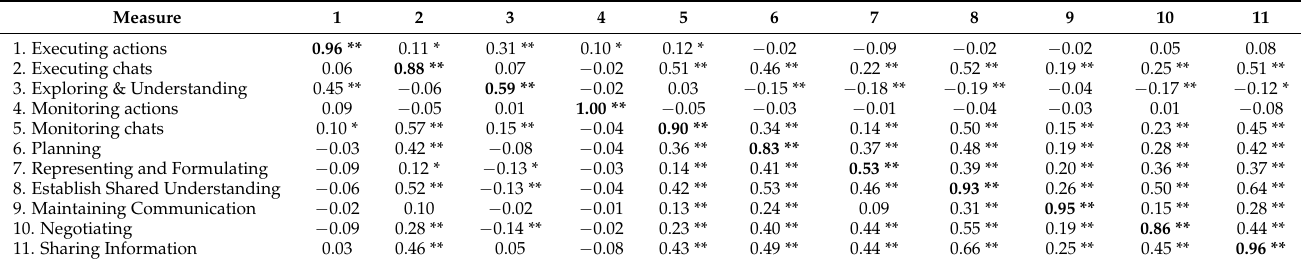
Table 3. Correlation of CPS codes across annotation